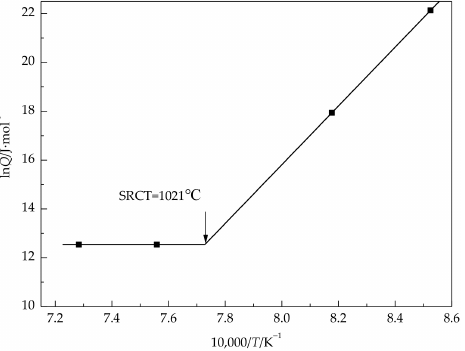
Figure 6. Plot of static recrystallization activation energy against the reciprocal of the absolute temperature.